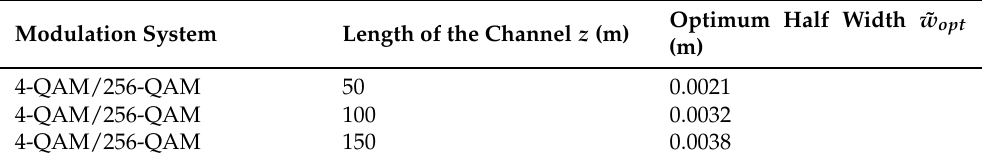
Table 3. The Relationship between the Optimal Half Beam-width of POV and the Topological Charge of OAM. Modulation